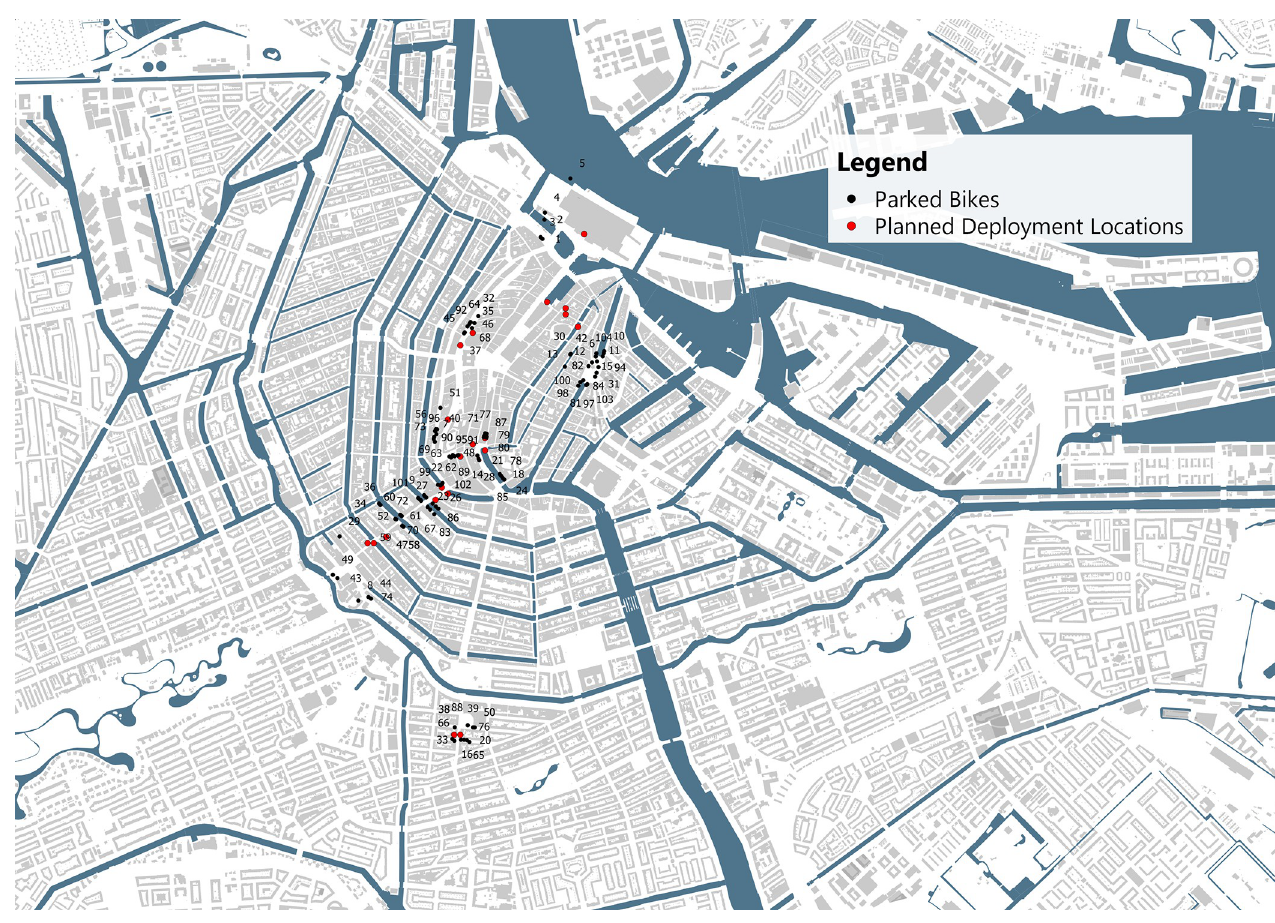
Fig 9. Planned deployment locations and realized parking locations of the 100 bikes. Base map data from OpenStreetMap.